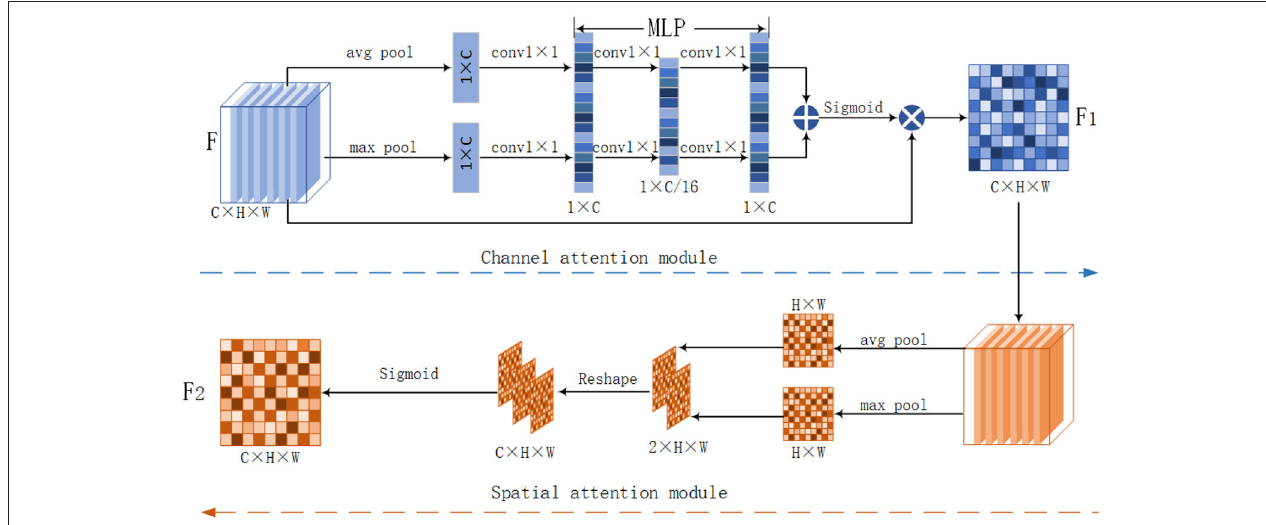
FIGURE 3 | CBAM module structure diagram. The module includes a channel attention module and a spatial attention module, for the input low light image, we first use the CBAM module to extract feature attention